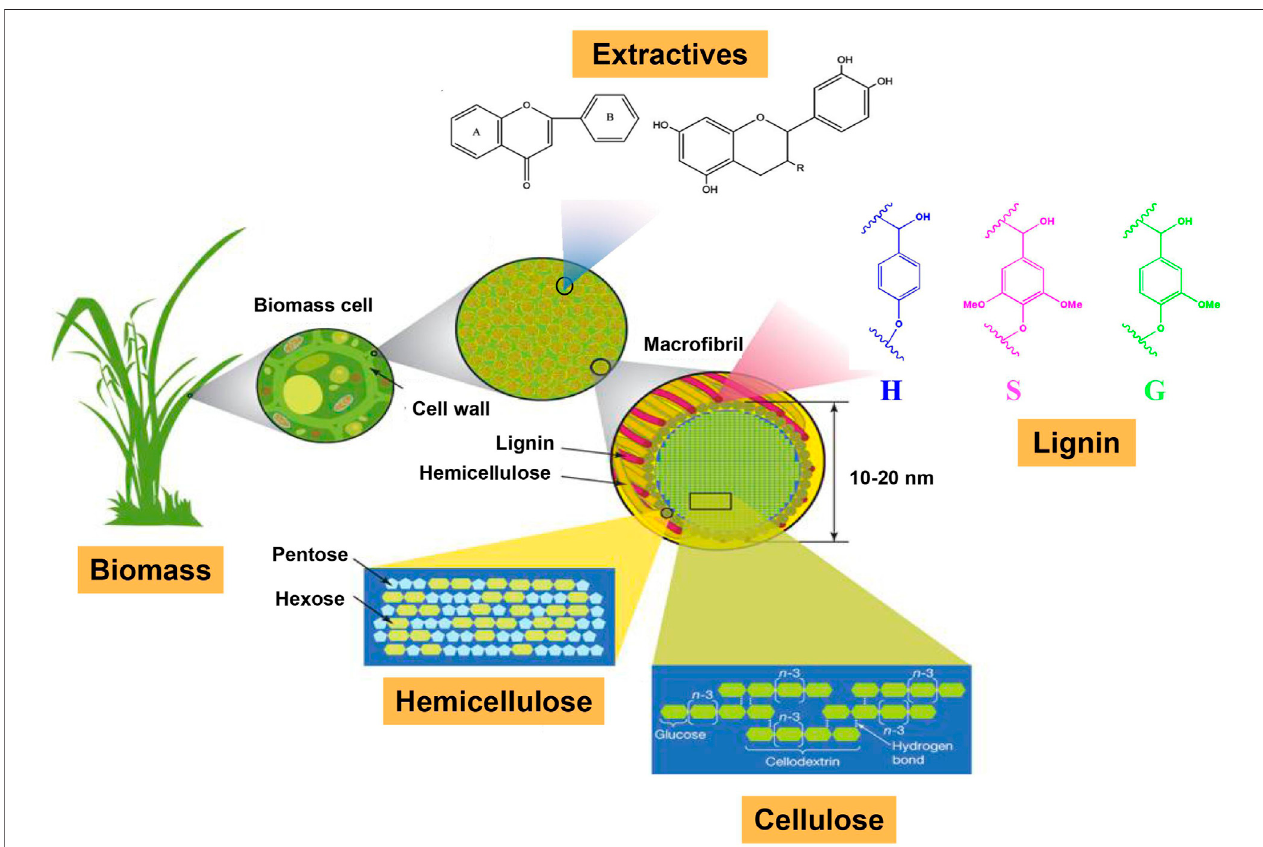
FIGURE 1 | The major components in